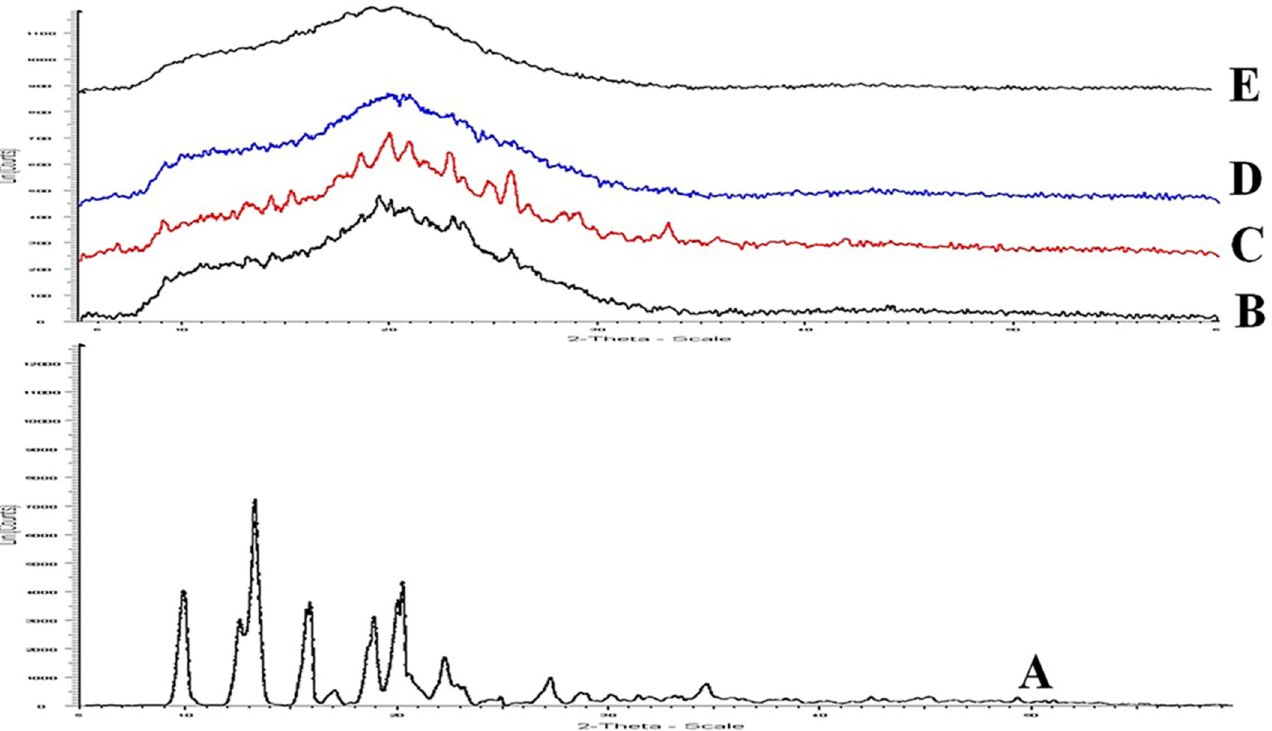
Figure 4. XRD Spectra of pure cytarabine ( A ), trehalose ( B ), neat TINPs ( C ), cytarabine-loaded TINPs (CY-TINPs) ( D ), and CY-TINPs ( E ) after 3 months.